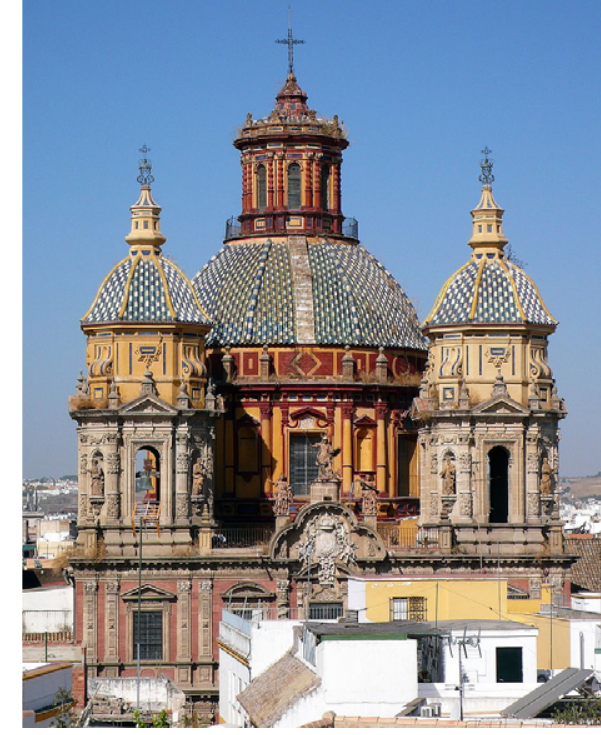
Figure 18: Exterior of the former Jesuit novitiate church of San Luis de los Franceses, Seville. Image from